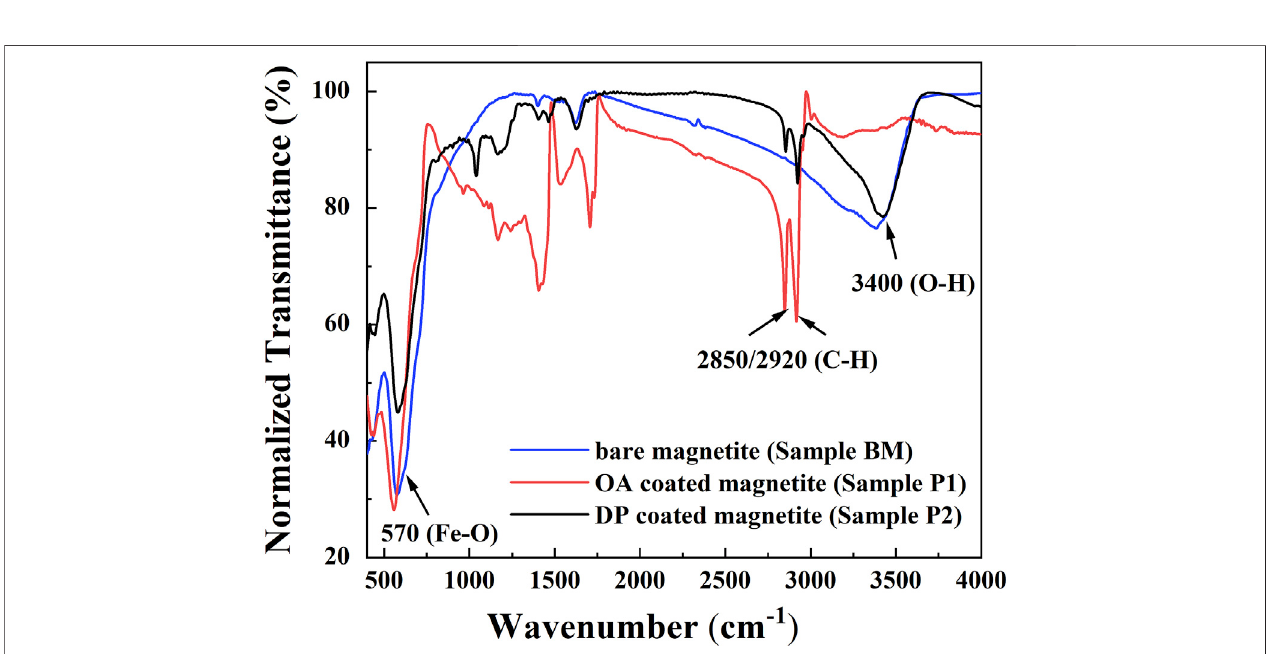
FIGURE 4 | FT-IR spectra of bare magnetite particles (BM), OA-coated particles (sample P1), and DP-coated magnetic nanoparticles (sample P2).